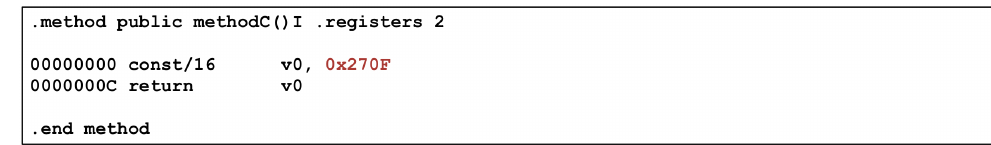
Figure 16. Disassembled MethodA and MethodB with ProGuard .